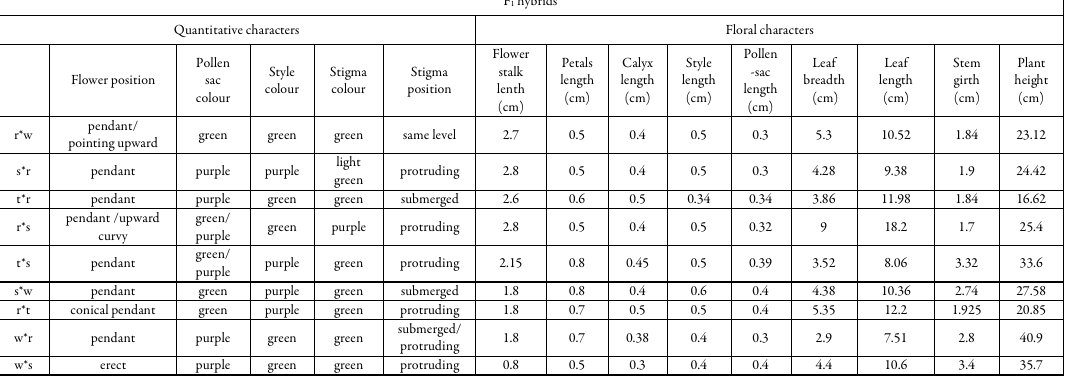
Table 5. Quantitative and floral data of F 1 hybrid plants